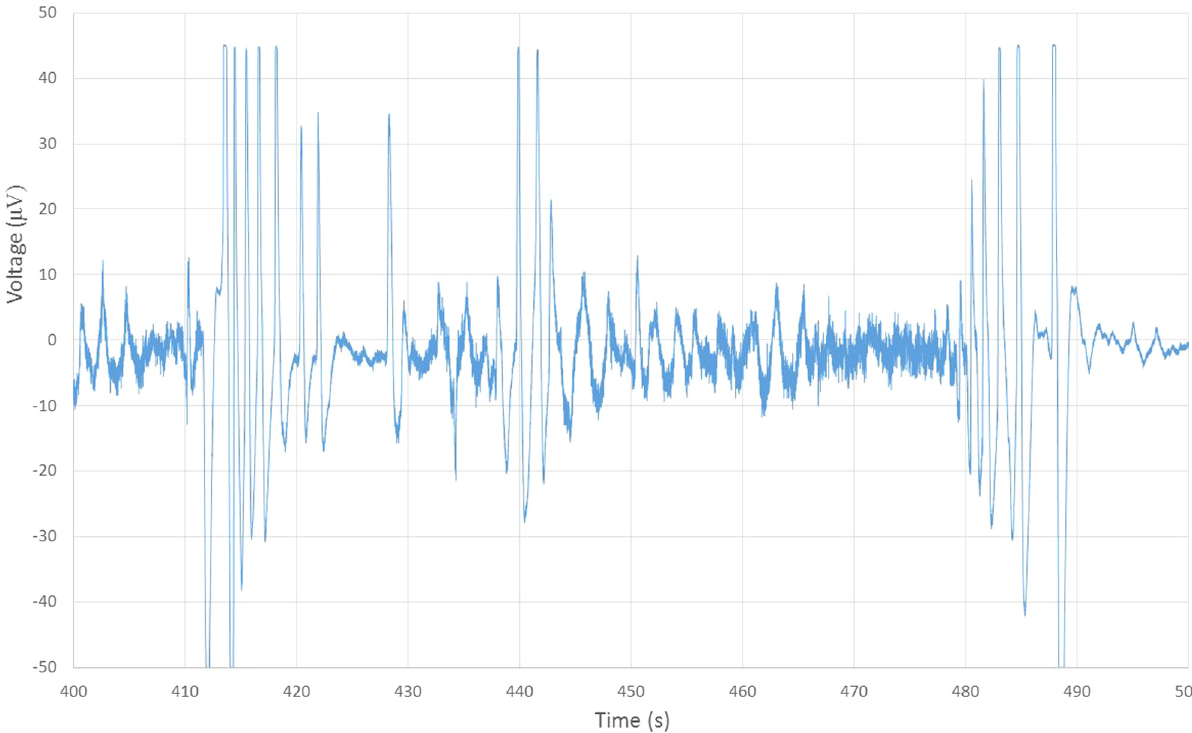
Figure 12: EMG of internal anal